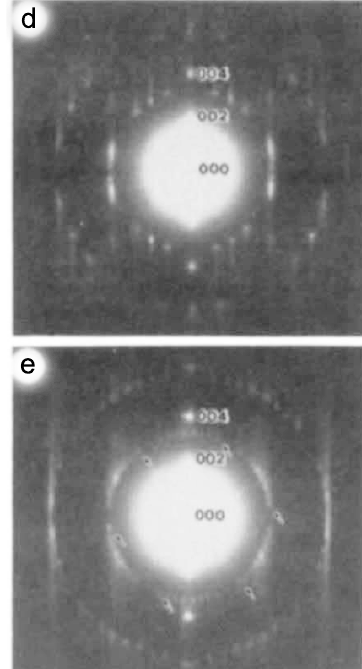
Figure A1. TEM image of nanotubes and sketches of each nanotube’s cross sections for ( a ) a five-wall nanotube with a diameter of 6.7 nm; ( b ) a double-wall nanotube with a diameter of 5.5 nm; and ( c ) a seven-wall nanotube with a diameter of 6.5 nm, which has the smallest hollow diameter ( ∼ 2.2 nm) among the three specimens; Electron diffraction patterns showing ( d ) the superposition of three sets of { hk 0 } spots taken from a seven-wall nanotube; and ( e ) the superposition of four sets of { hk 0 } spots from a nine-wall nanotube. Reprinted from Reference